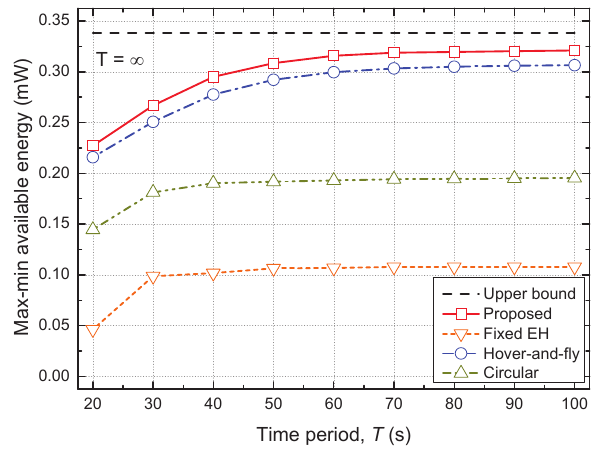
Figure 4. Max-min available energy vs. time period. Figure 4. Max–min available energy vs. time period.